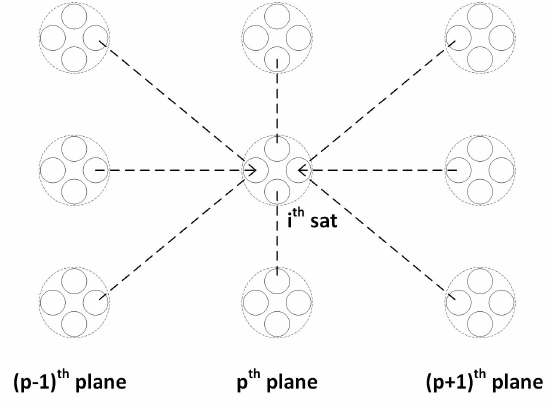
Figure 3. Representing ISL terminals as